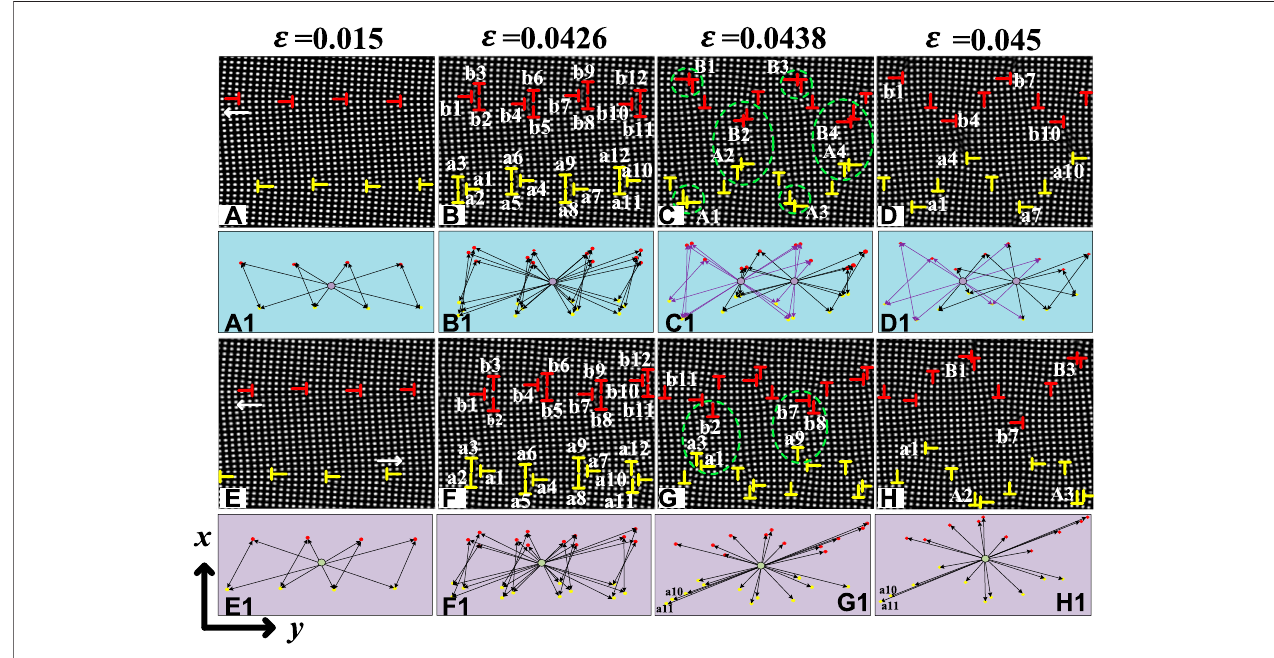
FIGURE 3 | (A – D), (A1-D1) The evolution and arrangement of grain boundary dislocations when the GBM are 7 ° , respectively. (E – H), (E1 – H1) The evolution and symmetry arrangement of grain boundary dislocations when the GBM are 6 ° , respectively. The strain ε is 0 . 015, 0 . 0426, 0 . 0438, and 0 . 045.